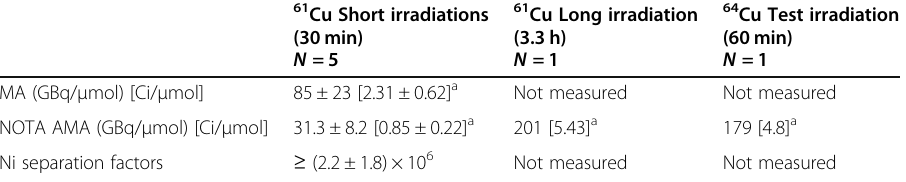
Table 5 Compilation of product MAs, AMAs and Ni separation factors for short and long